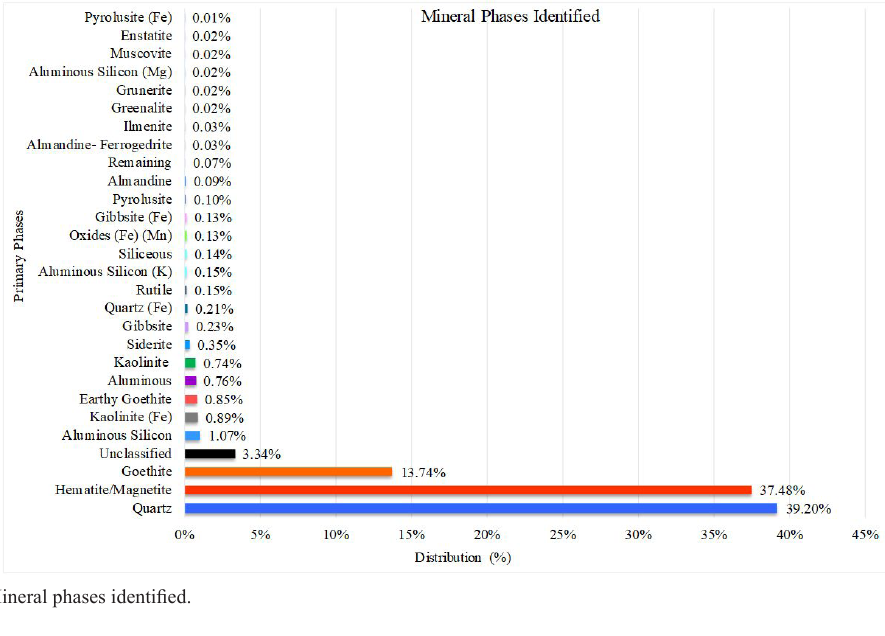
Figure 5. Mineral phases identified.